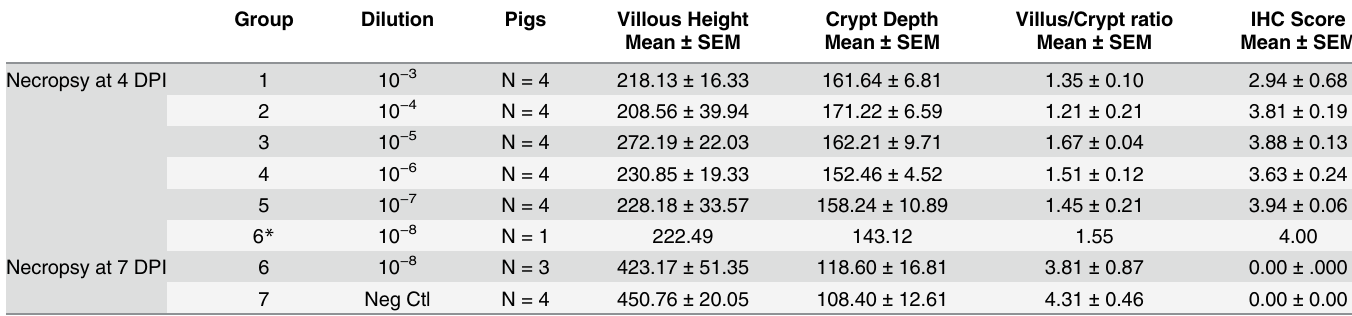
Table 4. Mean villus height ( μ m), crypt depth ( μ m), villus/crypt ratio, and IHC scores in sections of ileum from neonatal